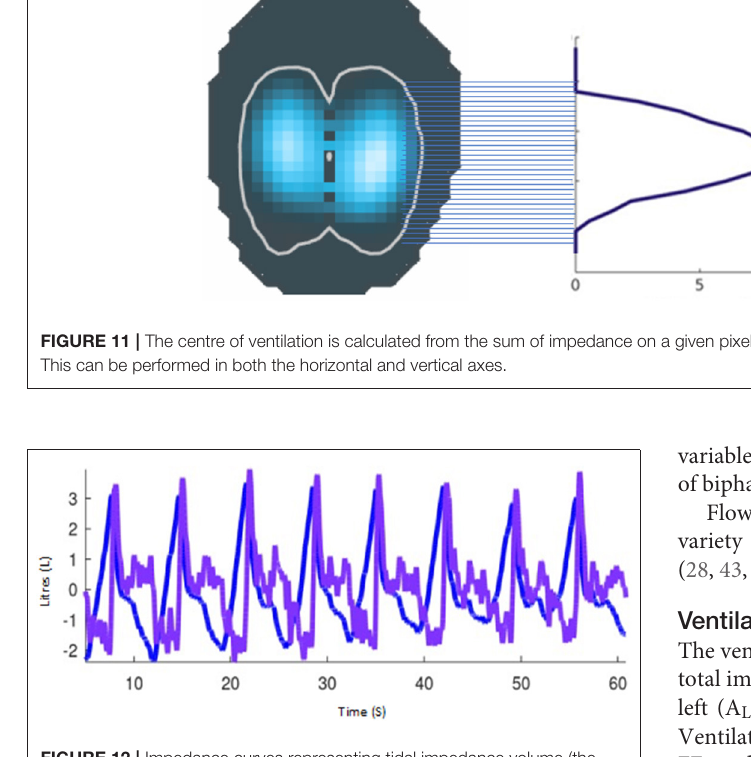
FIGURE 12 | Impedance curves representing tidal impedance volume (the volume signal; blue) and the first flow derivative, flow (purple) using Octave software (GNU, public licence,